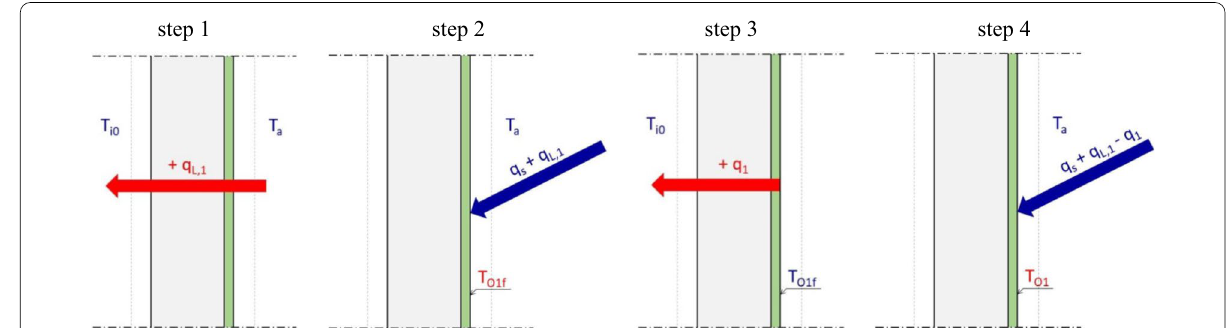
Fig. 6 Calculation steps of the one-dimensional model calculations for temperature and heat flow at the building